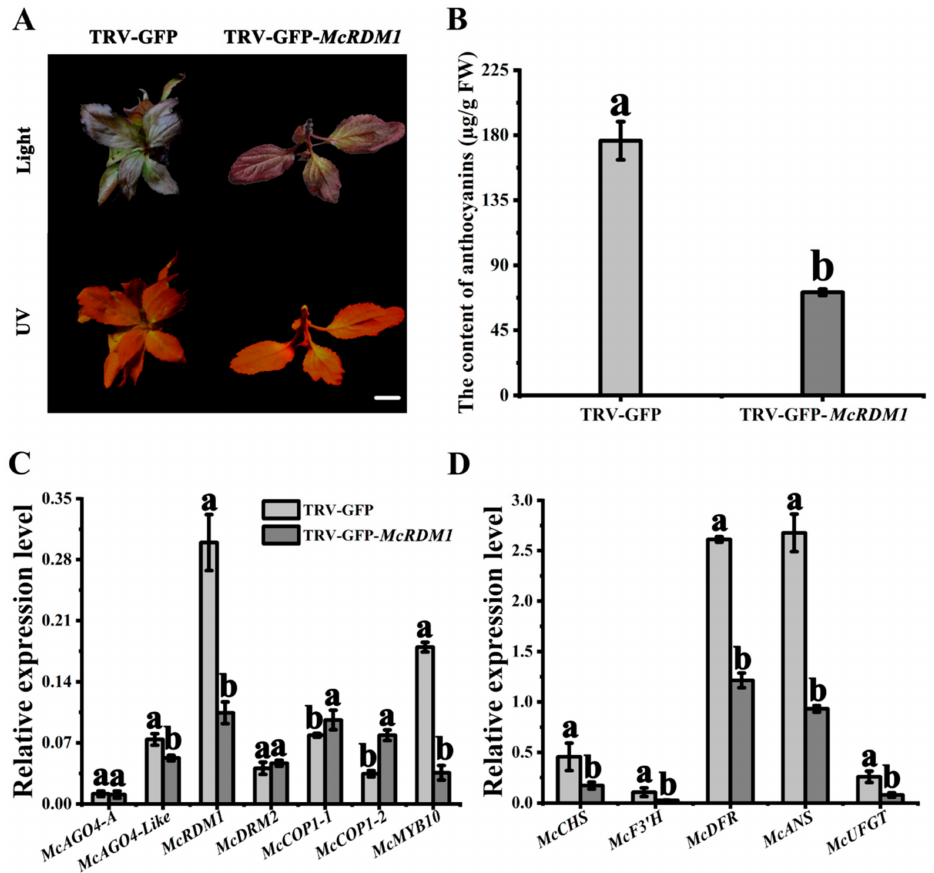
Figure 5. Effects of transient McRDM1 silencing in ‘Royalty’ leaves. ( A ). Phenotype of McRDM1 - silenced leaves. ( B ). Anthocyanin contents at the infiltration sites of crabapple leaves in µ g/g fresh weight (FW). ( C ). Relative transcript expression levels in leaves around the infiltration sites were determined using Real Time (RT)-quantitative (q) PCR. ( D ). Relative expression levels in crabapple leaves around the infiltration sites were determined using RT-qPCR. Bar = 2 cm. RT-qPCR and HPLC were performed with three biological replicates. Error bars indicate the standard error of the mean ± SE of three replicate measurements. Different letters above the bars indicate significantly different values ( p < 0.05), calculated using one-way analysis of variance (ANOVA) followed by a Duncan’s multiple range test. Scale bar = 1